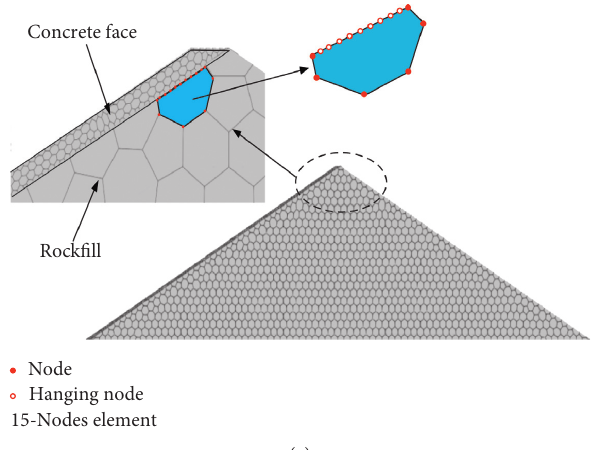
Figure 18: Mesh model of the CFRD: (a) Case 1, FEM model with a global element size of 0.06m; (b) Case 2, FEM model with a tie constraint; and (c) Case 3: PSBFEM model.